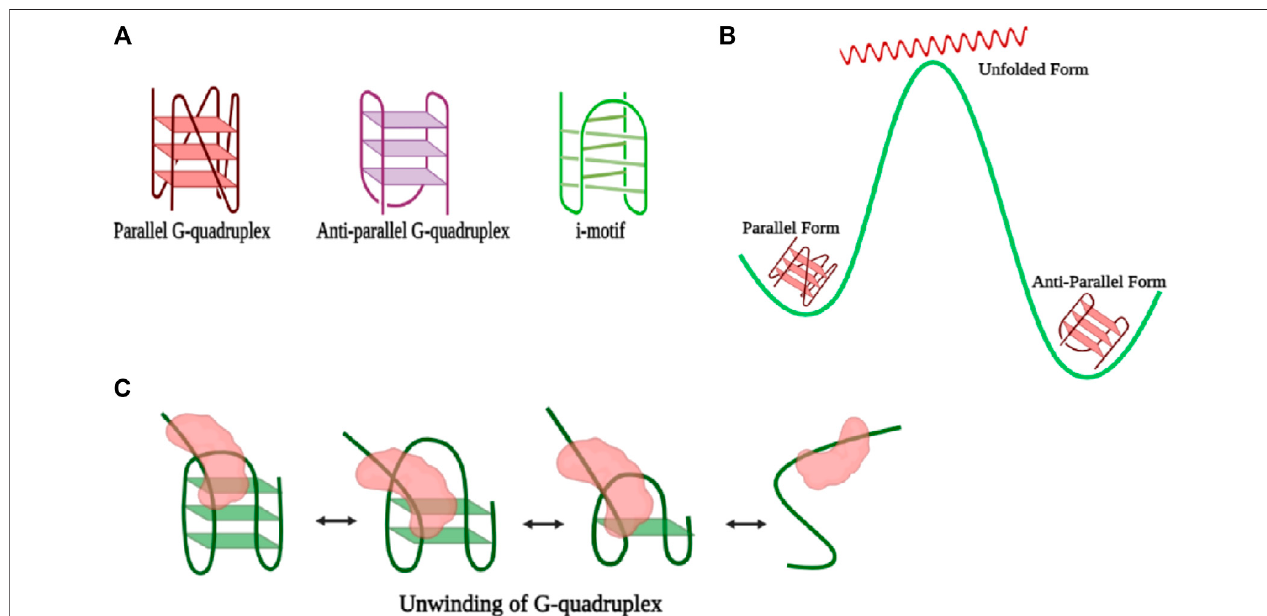
FIGURE 4 | (A) Representation of different forms of the G-quadruplex. (B) Illustration of the energy landscape of various types of G-quadruplexes where the antiparallelformisthemoststable;however,duringconversionfromtheantiparalleltotheparallelform,thereisattainmentofanintermediatehigh-energyunfoldedstate. (C) SchematicrepresentationofunwindingoftheG-quadruplexbyageneralhelicase(coloredinred).ThefoldingandrefoldingprocessoftheGQmotifisinterconvertible (created with